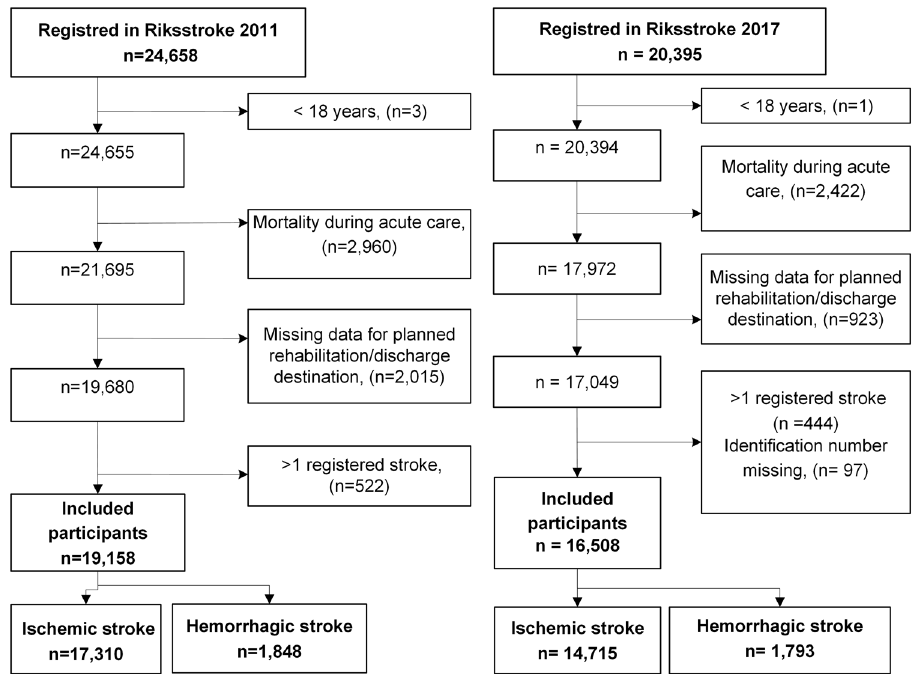
Figure 1. Flow chart showing the enrollment of participants in the study. Data from 2011 (left) and 2017 (right) are shown